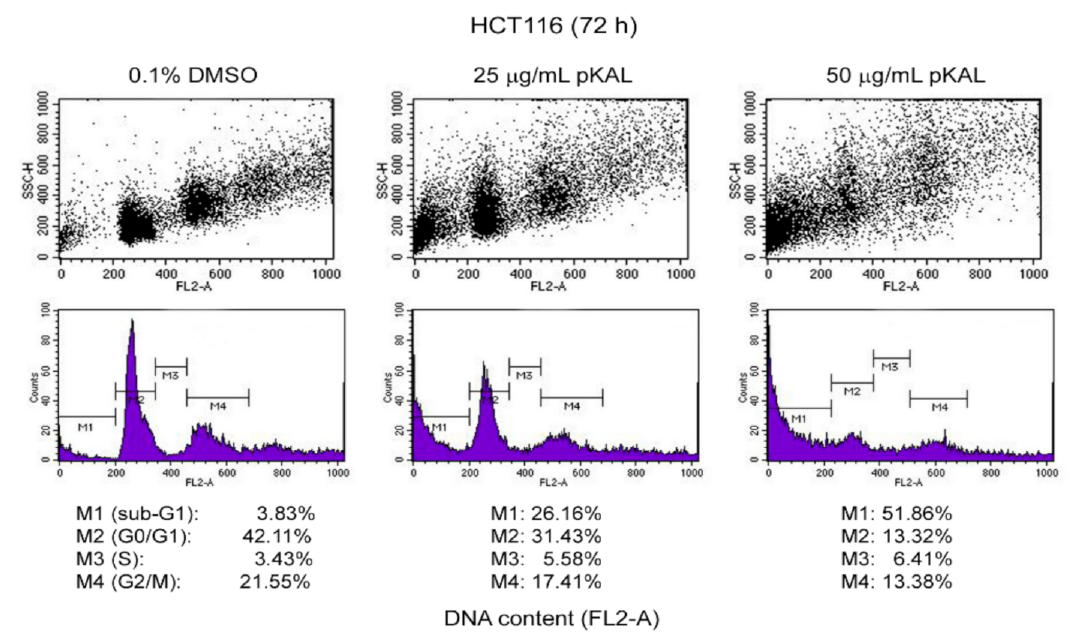
Figure 3. Effect of pKAL on the regulation of DNA content, cell cycle, and intracellular granularity: HCT116 cells were grown for 72 h with the indicated amount of pKAL. The floating and attached cells were analyzed by DNA content analysis using flow cytometry: top panels, dot plots for side scatter (SSC-H) and DNA content (FL2-A); bottom panels, DNA histograms for DNA content